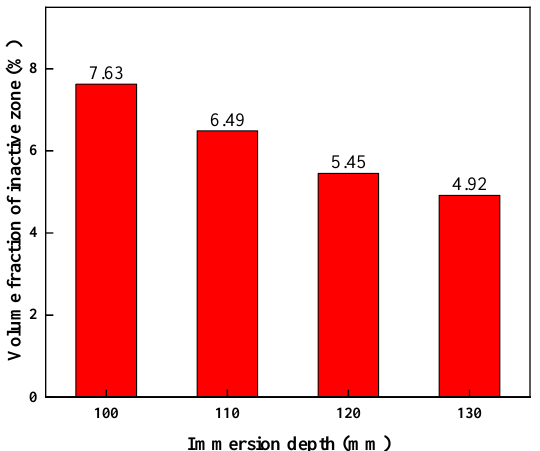
Figure 11. Comparison of the volume fraction of inactive zones at different IIDs.